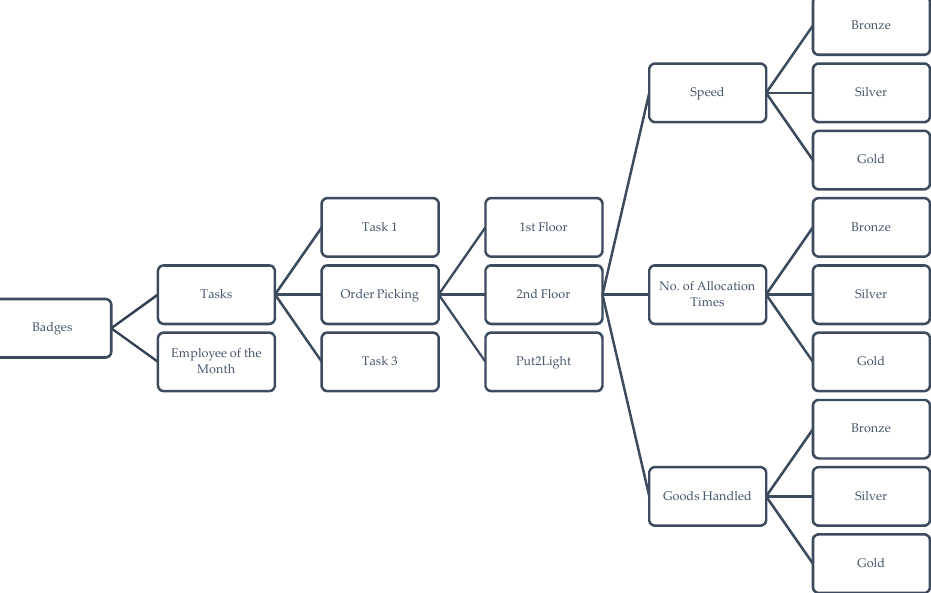
Figure 1. Typical badges’ structure.